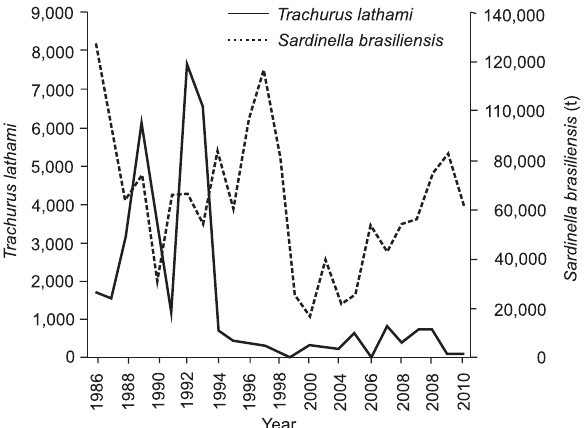
Figure 1. Commercial landings of Trachurus lathami and Sardinella brasiliensis in the Southeastern Brazilian Bight (SEBB). Data of 2008, 2009 and 2010 are restricted to states of Paraná and São Paulo that representing 95% of the total landings. Data source: Valentini and Pezzutto 2006, MMA 2007a, b, 2008 UNIVALI 2009, 2010, 2011, Instituto de Pesca